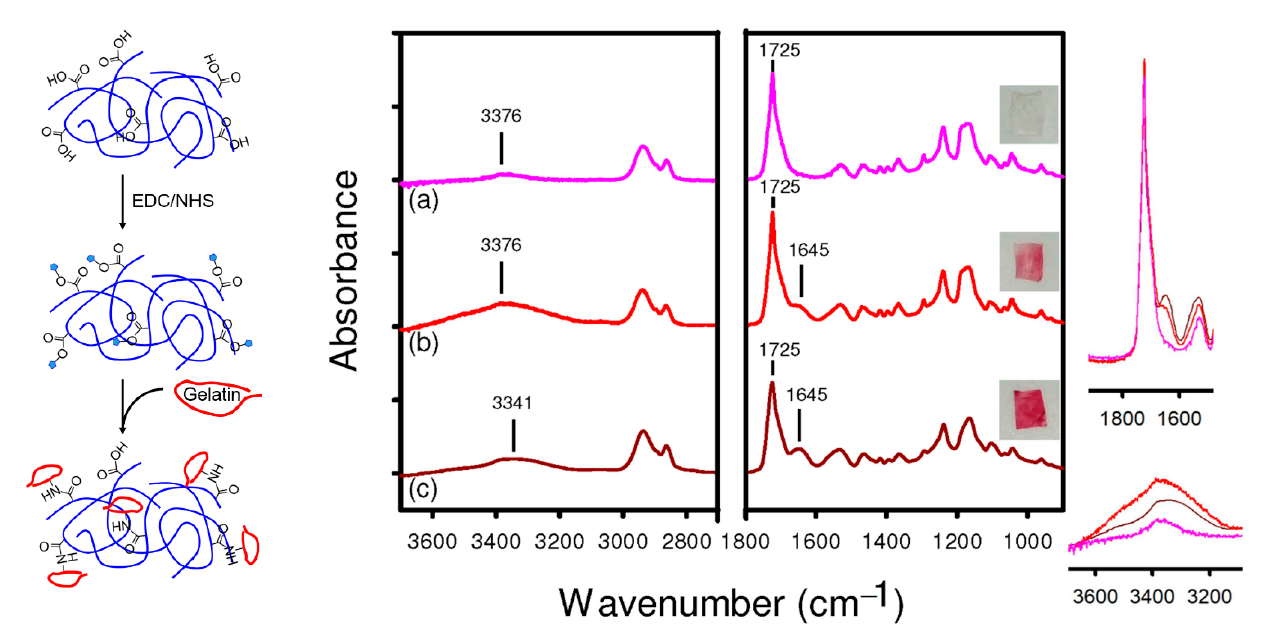
Figure 8. Left : schematic of the gelatin immobilization on the PU-DMPA electrospun fibers. Right : ATR-FTIR spectra of the PU-DMPA solid film ( a ), the gelatin-modified PU-DMPA solid film ( b ), and the gelatin-modified PU-DMPA electrospun fibrous mesh ( c ). The inserts on the right illustrate their corresponding Ponceau S staining.